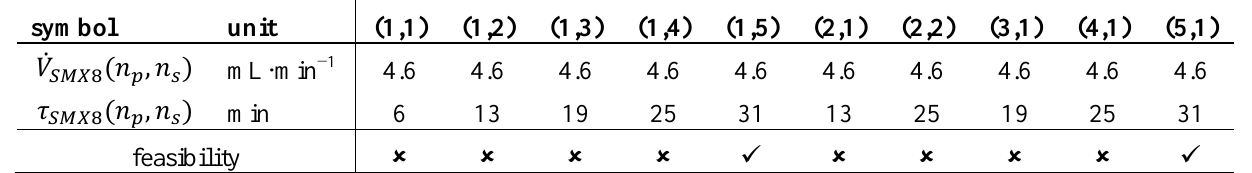
Table 6. Results for SMX8 after the residence time